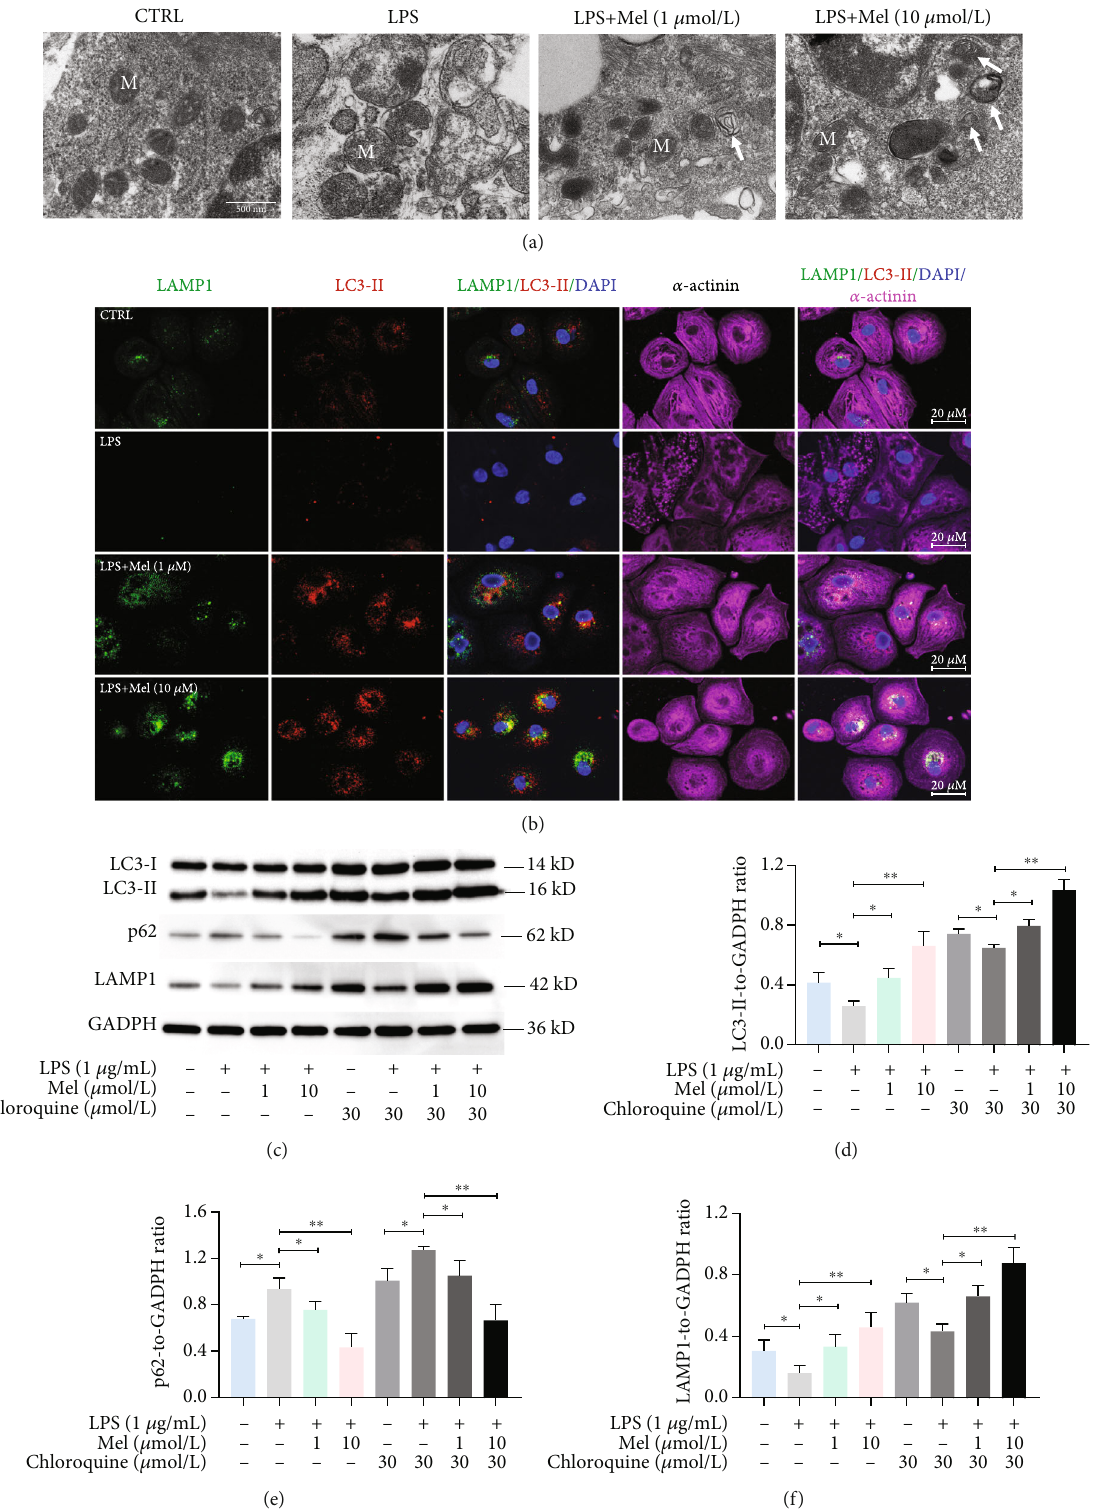
Figure 5: Melatonin promotes autophagy in LPS-exposed hiPSC-CMs. (a) Transmission electron microscope images of hiPSC-CMs in LPS +MEL (1 μ mol/l) and LPS+MEL (10 μ mol/l) cells. M indicates representative mitochondria. Arrows indicate autophagosomes. Scale bar: 500nm. (b) Representative immuno fl uorescent images for LAMP1 (green), LC3-II (red), α -actinin (purple), and DAPI (blue). Scale bar: 20 μ m. (c) Representative immunoblots of LC3-II, p62, and LAMP1. (d) Quantitative analysis of LC3-II. (e) Quantitative analysis of p62. (f) Quantitative analysis of LAMP1. n ≥ 3 ; ∗ P < 0 : 05 ; ∗∗ P < 0 : 01